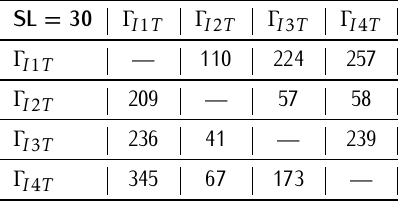
5. Non-unique matching light segments between measurements for trajectory (I) Timis oara to Deva (path ,